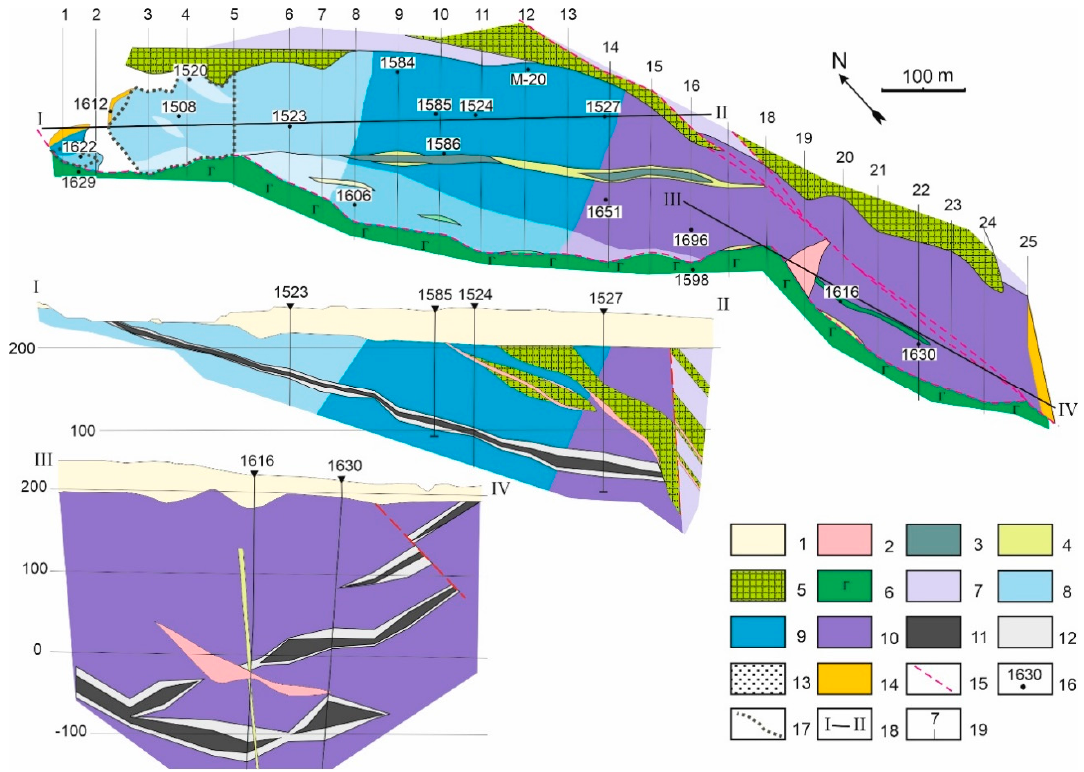
Figure 4. Geological map of the Sopcheozero deposit and longitudinal sections [1,2]. (1) Moraine; (2) microgranite vein; (3) orthopyroxenite and norite dykes; (4) dyke of coarse-grained norite; (5) microgabbro and microdiorite dykes; (6) gabbroanorthosite of the Monchetundra massif; (7) barren and (8–10) ore-bearing ultramafic rock of the Dunite Block: (8) plagioharzburgite, (9) plagiodunite, (10) dunites; (11) rich and ordinary chromitite ores; (12) poor chromitite ore; (13) serpentinized ultramafic rocks; (14) rocks overlapped by a moraine; (15) faults; (16) borehole position and its number; (17) contour of an open pit; (18) geological section and its number; (19) exploration profile and its number.